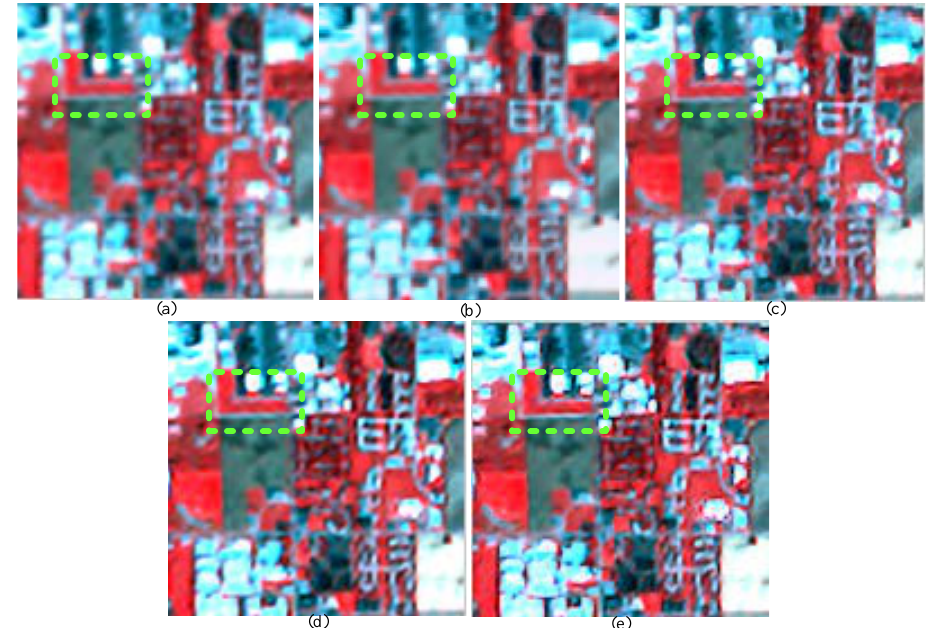
Figure 14. False color composite (band 45, 21, 14) of the enlarged area in the yellow box of Figure 12. The size of the area is 200 × 200. ( a ) Result of Bicubic, ( b ) result of SSGS [27], ( c ) result of SRCNN [40], ( d ) result of 3D-CNN [32], and ( e ) result of MW-3D-CNN. Table 5. The no-reference assessment scores of super-resolved 15 m Hyperion HSI. SR Methods